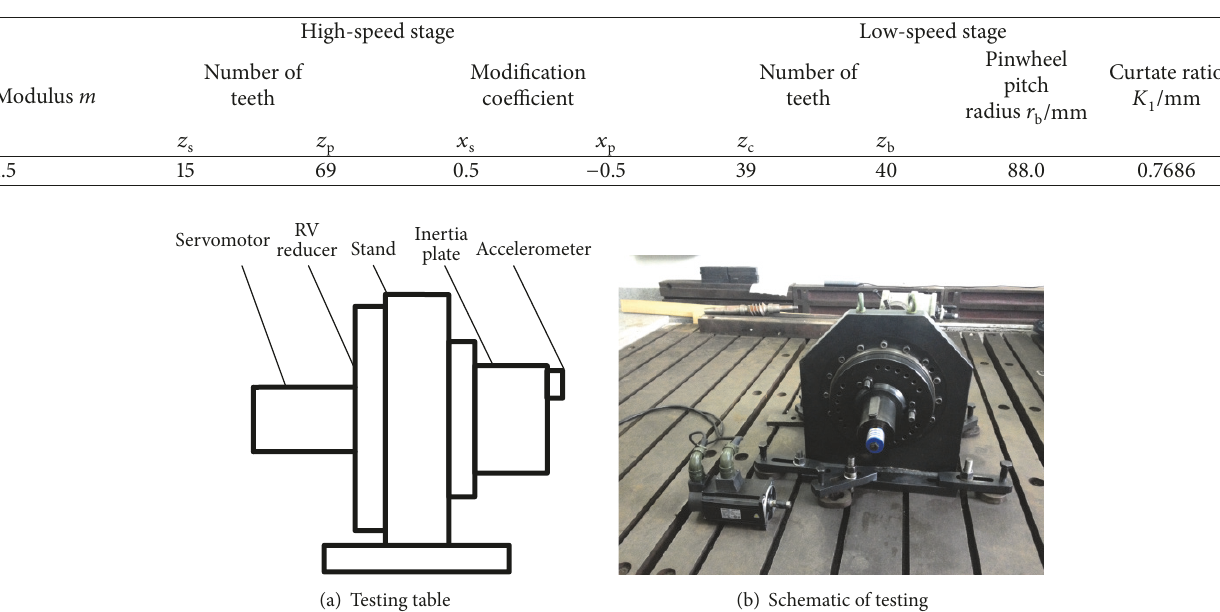
Table 4: Basic parameters of engineering prototype.